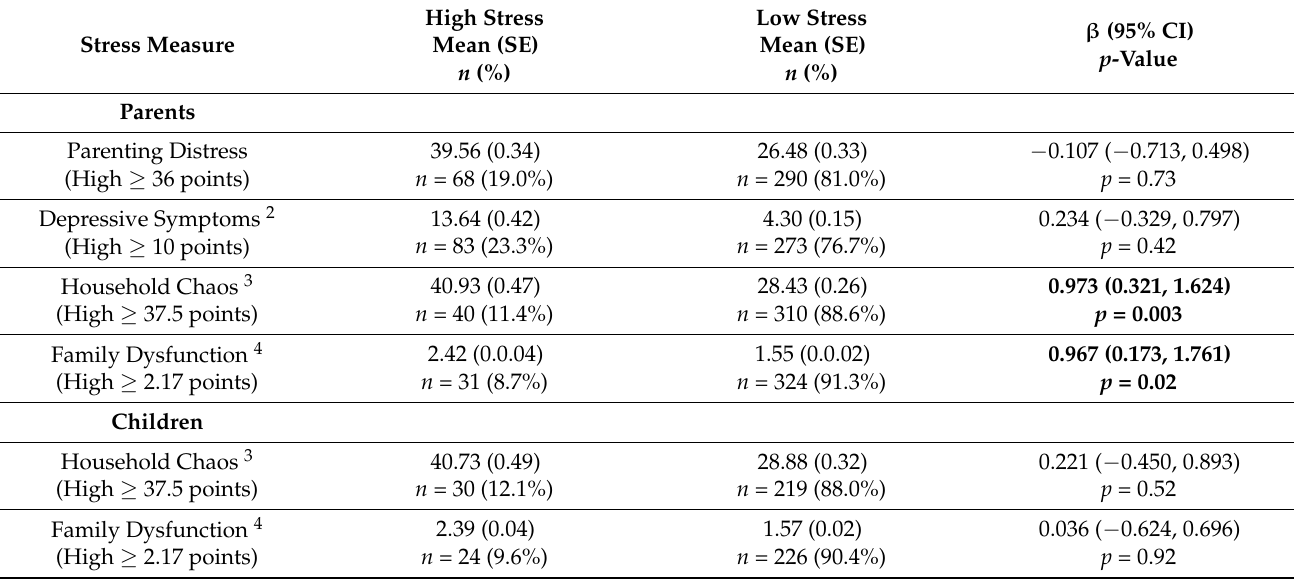
Table 3. Associations between family stress levels and Dietary Inflammatory Index scores 1 among preschool-aged children and their parents ( n = 241 families). Results presented as means (SE) with linear regression coefficient estimates ( β ) using generalized estimating equations with 95% confidence intervals (CI) and p -values (significant findings shown in